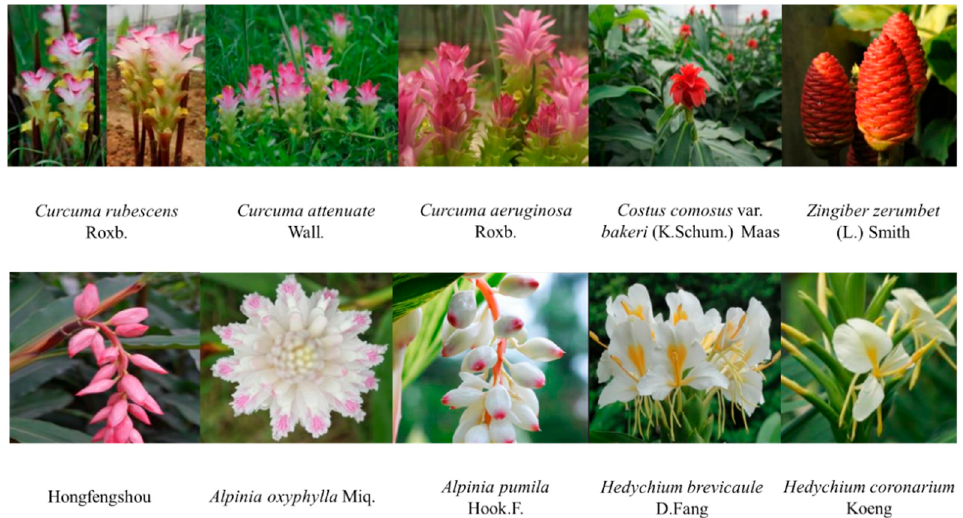
Figure 1. These are pictures of ten species of Zingiberaceae. Curcuma rubescens Roxb.; Curcuma attenuate Wall.; Curcuma aeruginosa Roxb.; Costus comosus var. bakeri (K.Schum.) Maas; Zingiber zerumbet (L.) Smith; a new Alpinia cultivar, Hongfengshou; Alpinia oxyphylla Miq.; Alpinia pumila Hook.F.; Hedychium brevicaule D. Fang; and Hedychium coronarium Koeng.